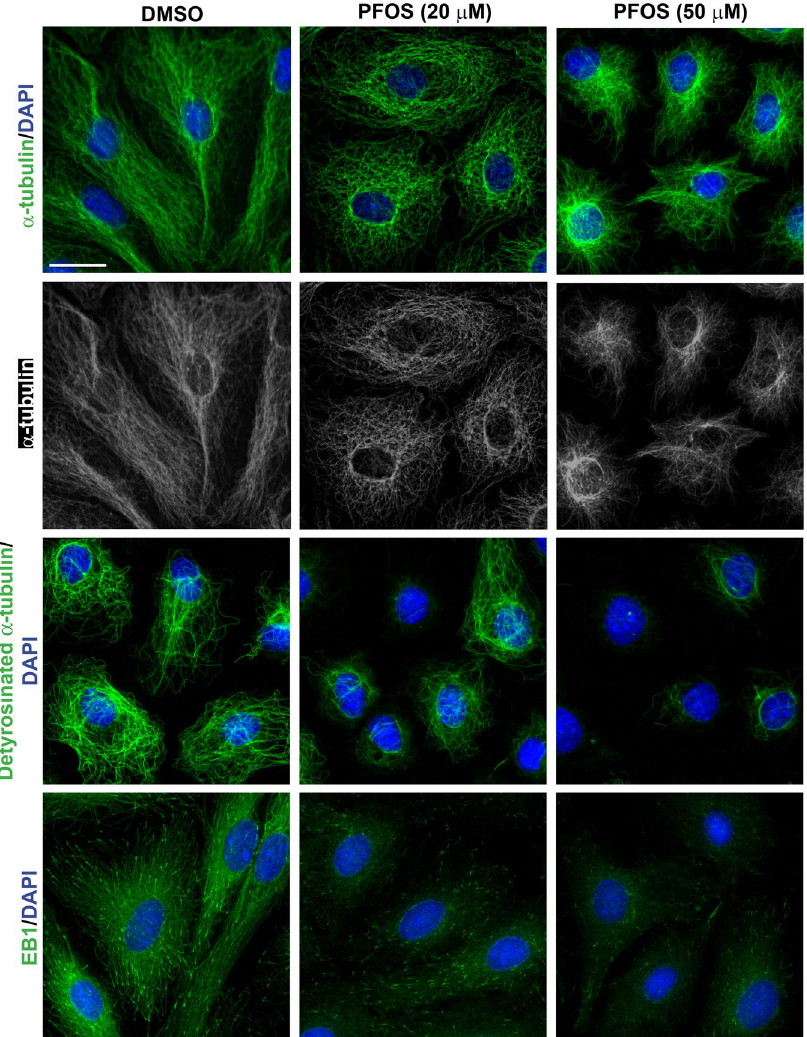
Figure 5. PFOS induces disorganization of microtubules (MTs) through its disruptive effects on the localization of α -tubulin and detyrosinated α -tubulin, and MT regulatory protein EB1. Sertoli cells cultured for 3 days at a density of 0.03 × 10 6 cells/cm 2 . Cells were then treated with either 20 or 50 μ M PFOS for 24 hr. Thereafter, cells were fixed with ice-cold methanol and visualized by immunofluorescence microscopy. In control cells, α -tubulin, the building block of MTs, stretched across the entire Sertoli cell to support cell shape and served as tracks for intracellular transport and trafficking. Following PFOS treatment, there was a dose-dependent retraction of MTs across the cell cytosol wherein MTs no longer stretched across the cytosol but encircled the Sertoli cell nuclei instead. Detyrosinated α -tubulin, the stabilized form of MTs, was considerably diminished dose-dependently, consistent with findings shown in Fig. 1B. Interestingly, the spatial expression of EB1, a + TIP (plus-end tracking protein) was considerably disrupted since it no longer expressed prominently across the MTs as noted in control Sertoli cells, but apparently dispersed in the cell cytosol since the overall expression of EB1 was not shown to be down-regulated as noted by immunoblotting shown in Fig. 1B. Sertoli cell nuclei were visualized by DAPI. Scale bar, 30 μ m, which applies to all other